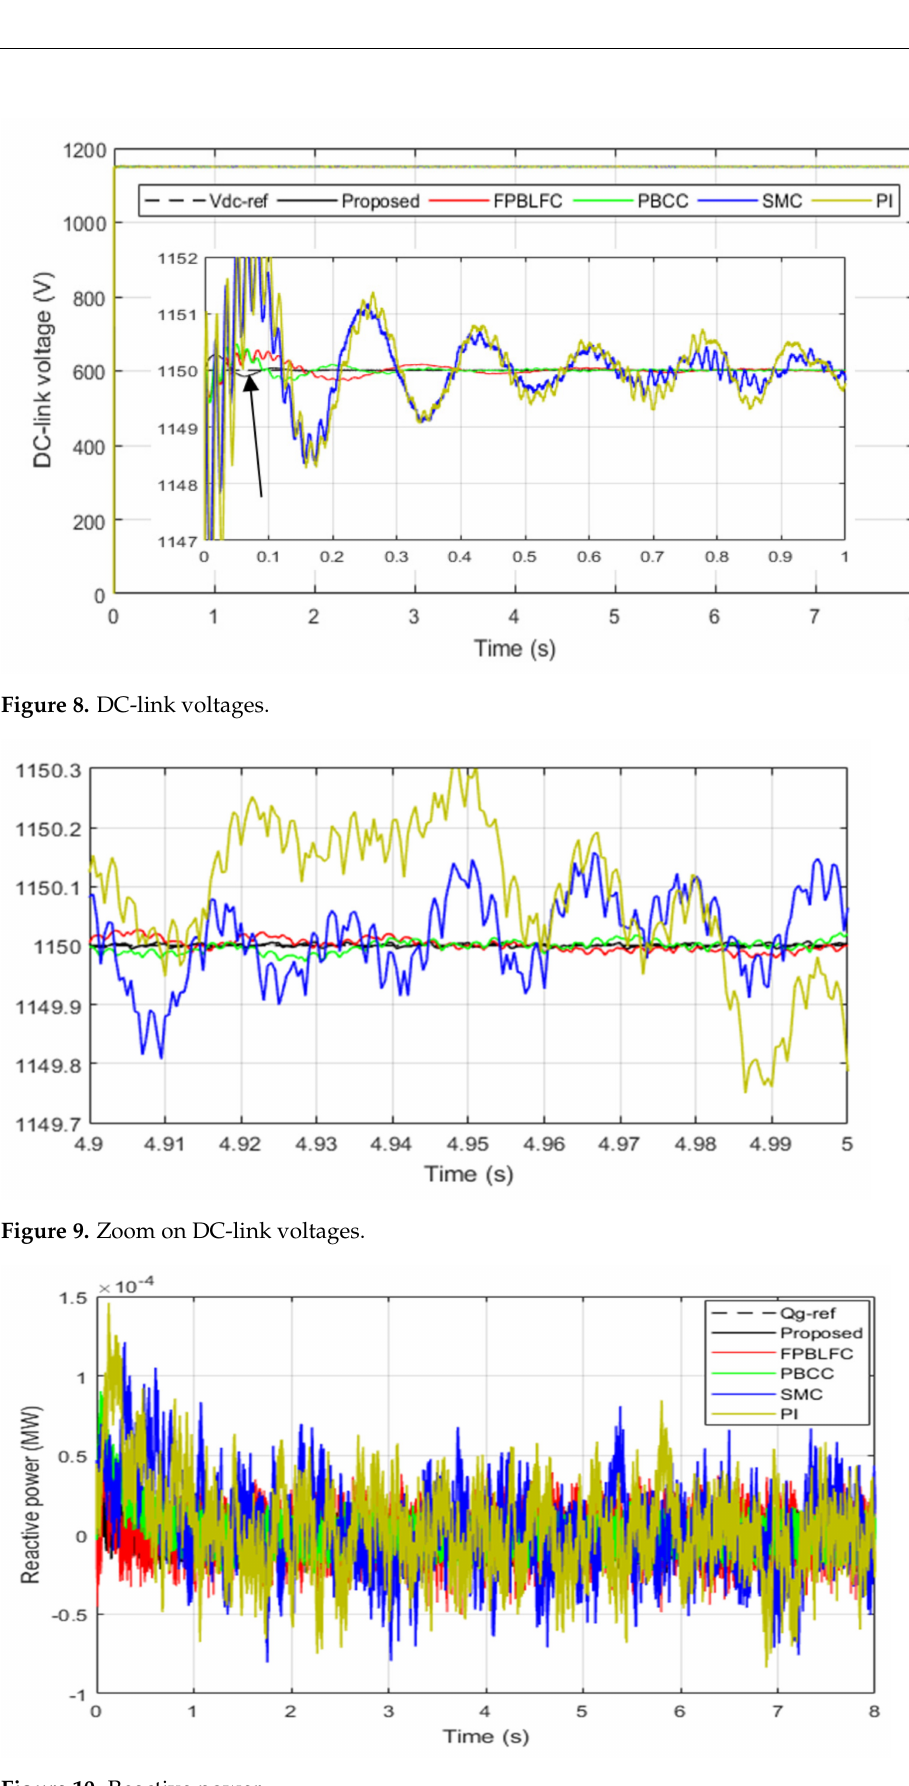
Figure 10. Reactive